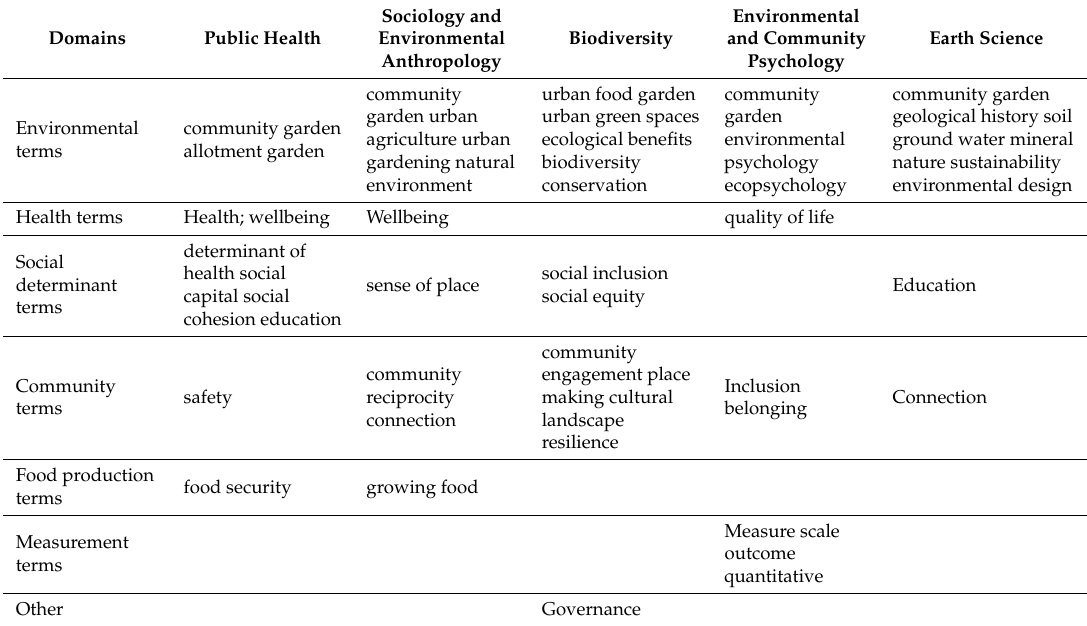
Table 1. Transdisciplinary community garden search